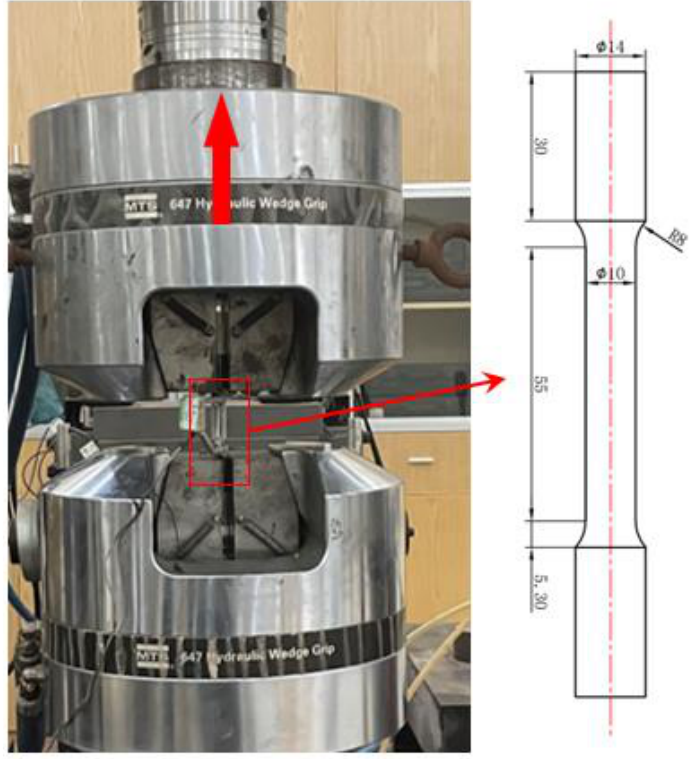
Figure 6. Schematic diagram of bolt material test (unit: mm).